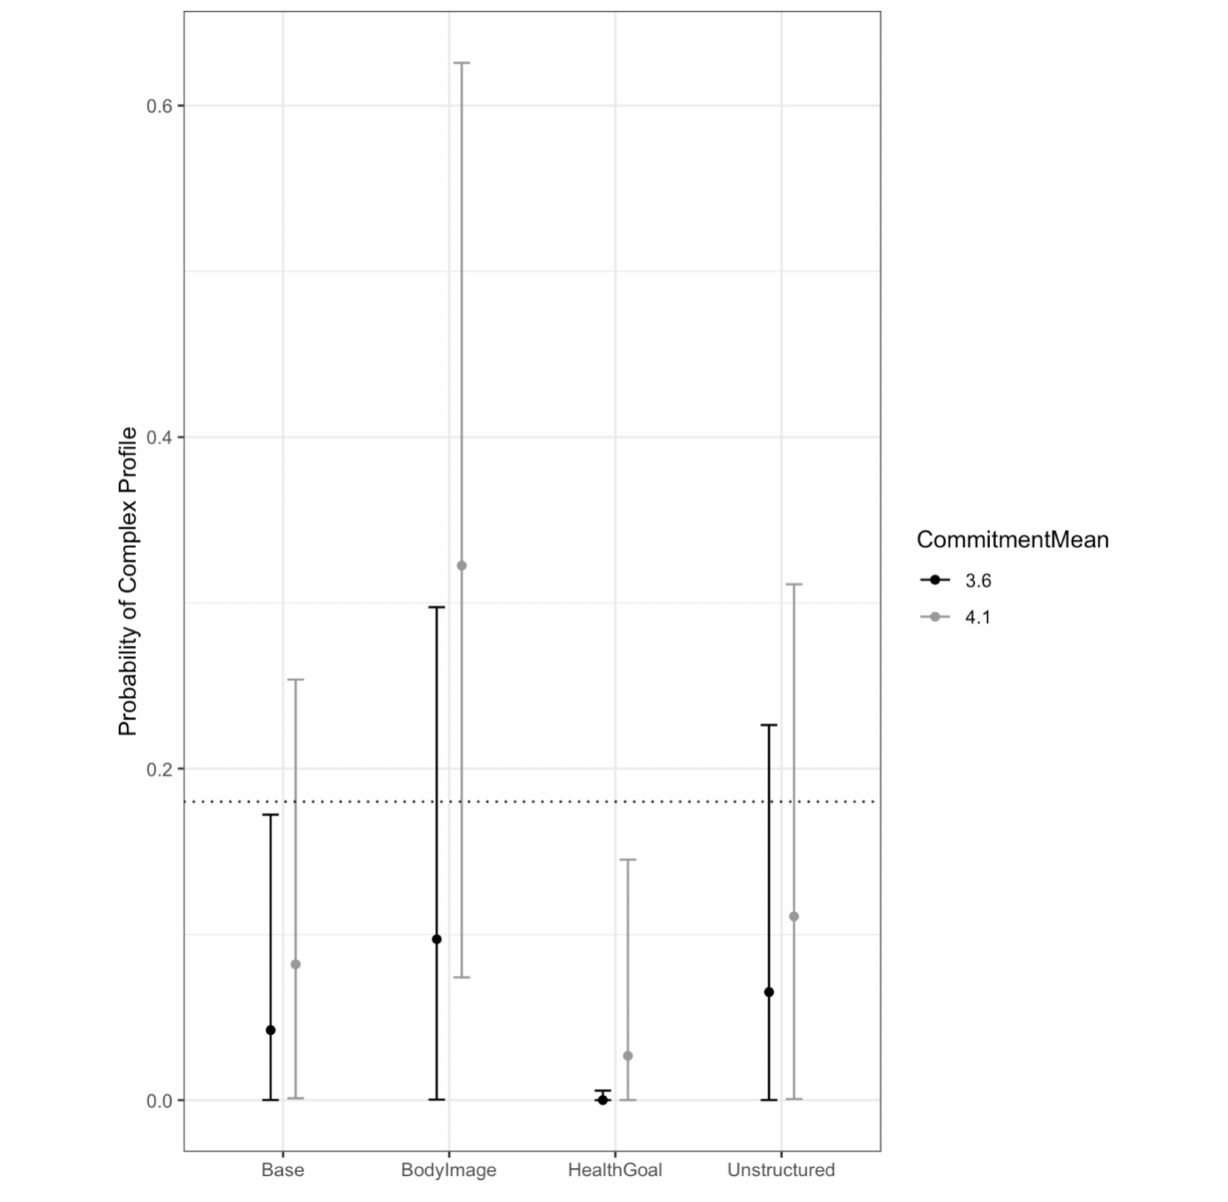
FIGURE 5 | The interaction of average commitment and context. The dotted line shows the unconditional probability of being in the complex profile as a reference point. Higher average commitment was associated with a higher probability of being in the complex profile during the Health Goals conversation, although this is due to low commitment couples having an essentially zero probability of being in the complex profile while discussing health goals, rather than high commitment couples being likely to be in the complex profile during that